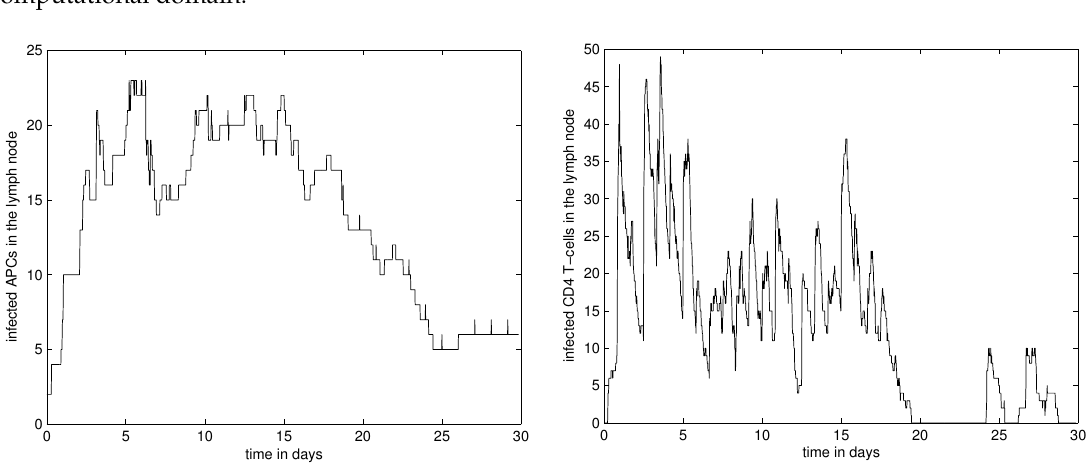
Figure 4. ( left ) The dynamics of the population of HIV-infected APCs in the lymph node; ( right ) The dynamics of the population of HIV-infected CD4 + T cells in the lymph node.